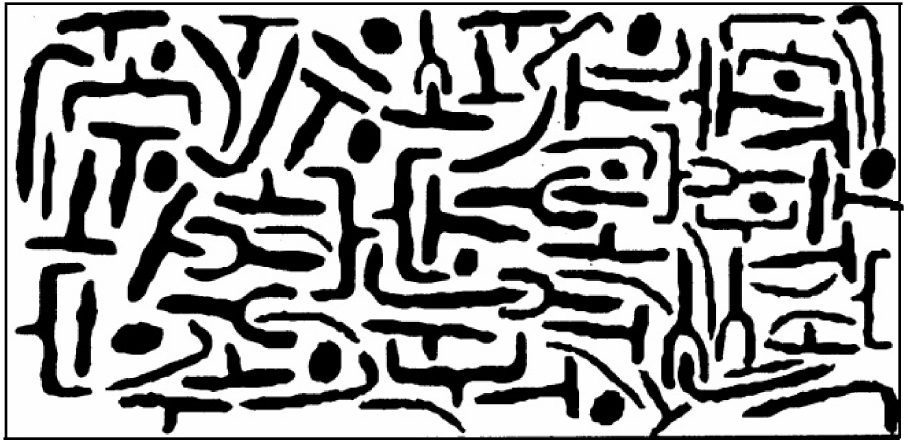
Figure 2. Model of the chemical structure of bitumen developed in the SHRP program [13]. The polar hydrocarbon systems are shown in black, while the white denotes the area representing nonpolar